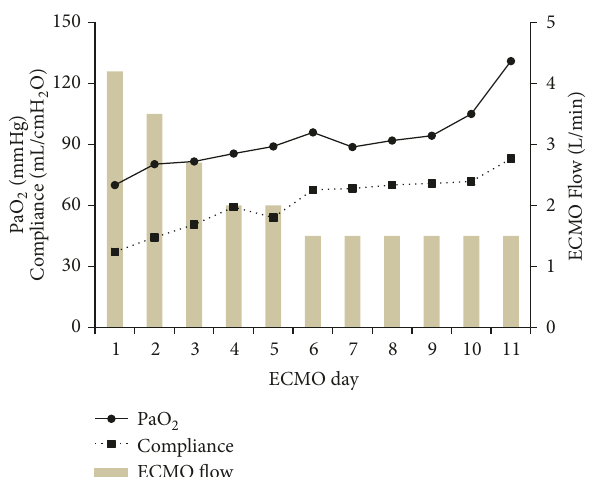
Figure 3: Partial pressure of arterial oxygen (PaO 2 ) and compliance during extracorporeal membrane oxygenation